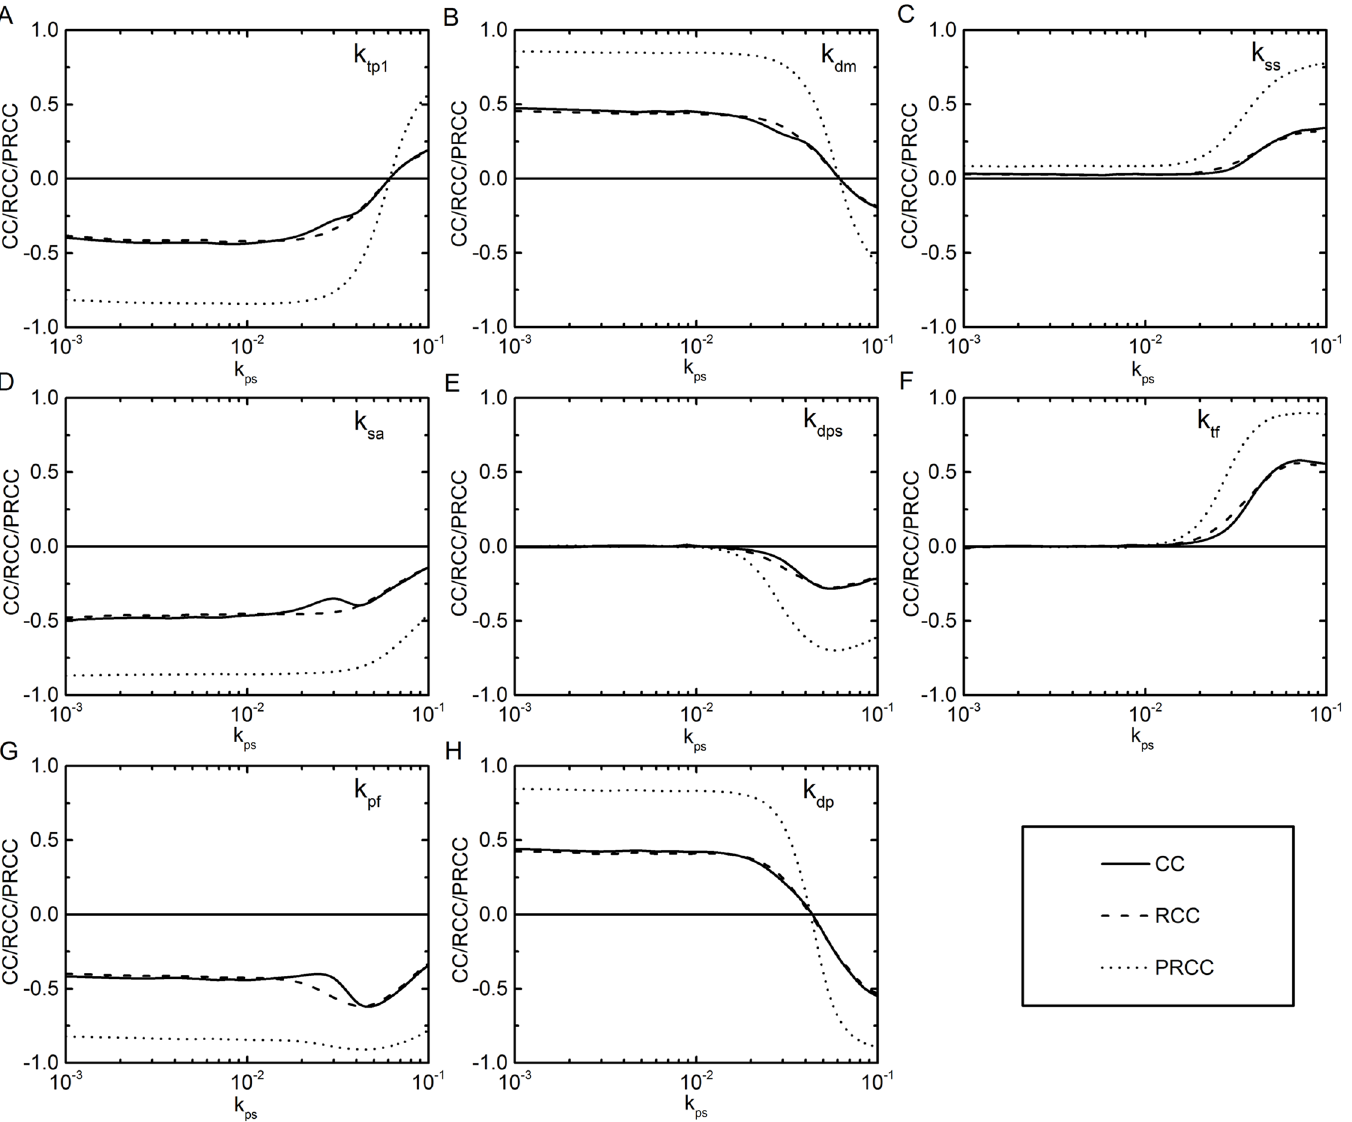
Fig 3. Correlation coefficients. The correlation coefficients CC (solid line), RCC (dashed line) and PRCC (dotted line) as a function of input signal k ps . A, B, C, D, E, F, G and H are for k tp 1 , k dm , k ss , k sa , k dps , k tf , k pf and k dp , respectively. Note the logarithmic scale in the